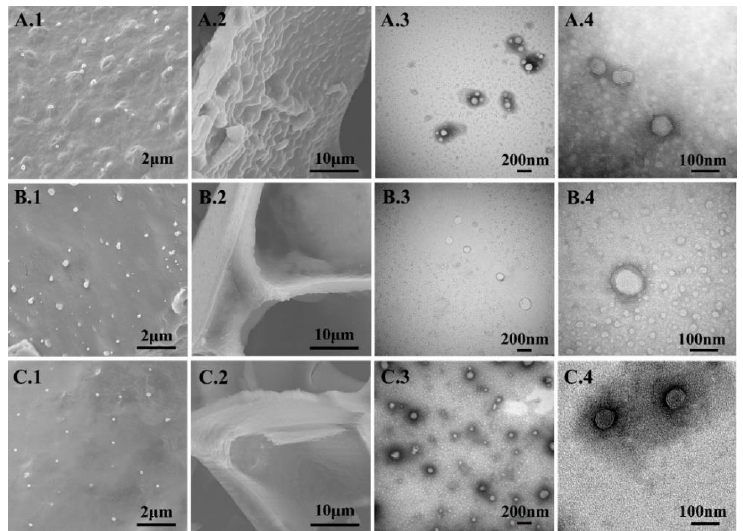
Figure 4. Micrographs of lyophilized and reconstituted samples. ( A ) 8%-T, ( B ) 8%-L, and ( C ) 8%-L-T, 1 and 2 are SEM images, 1 morphology at low magnification and 2 morphology